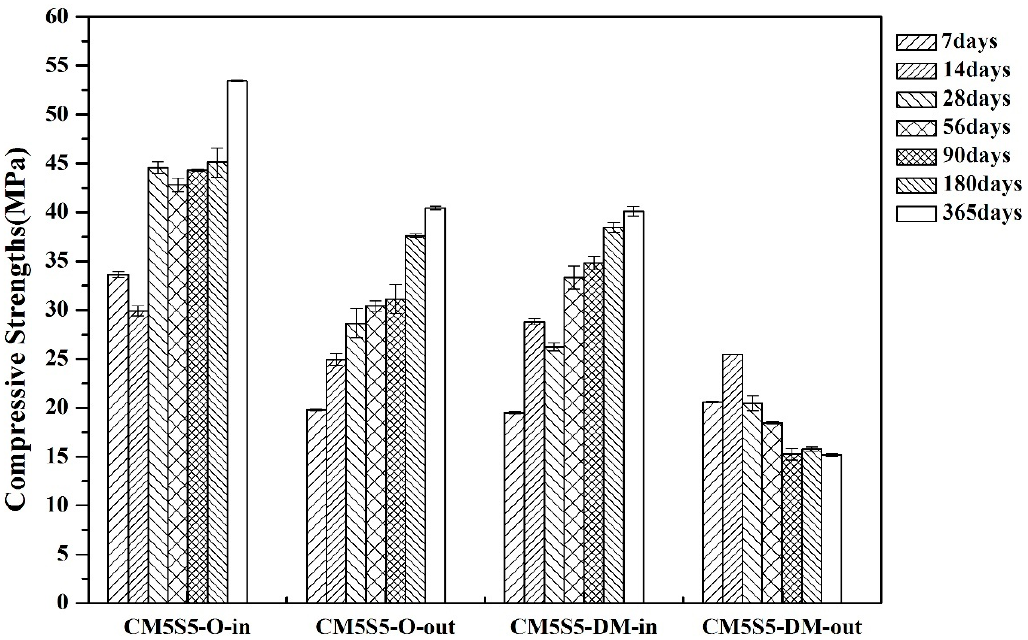
Figure 3. Effect of the binder ratio and curing environment on the compressive strength of marble-based geopolymer concrete under indoor and outdoor curing.